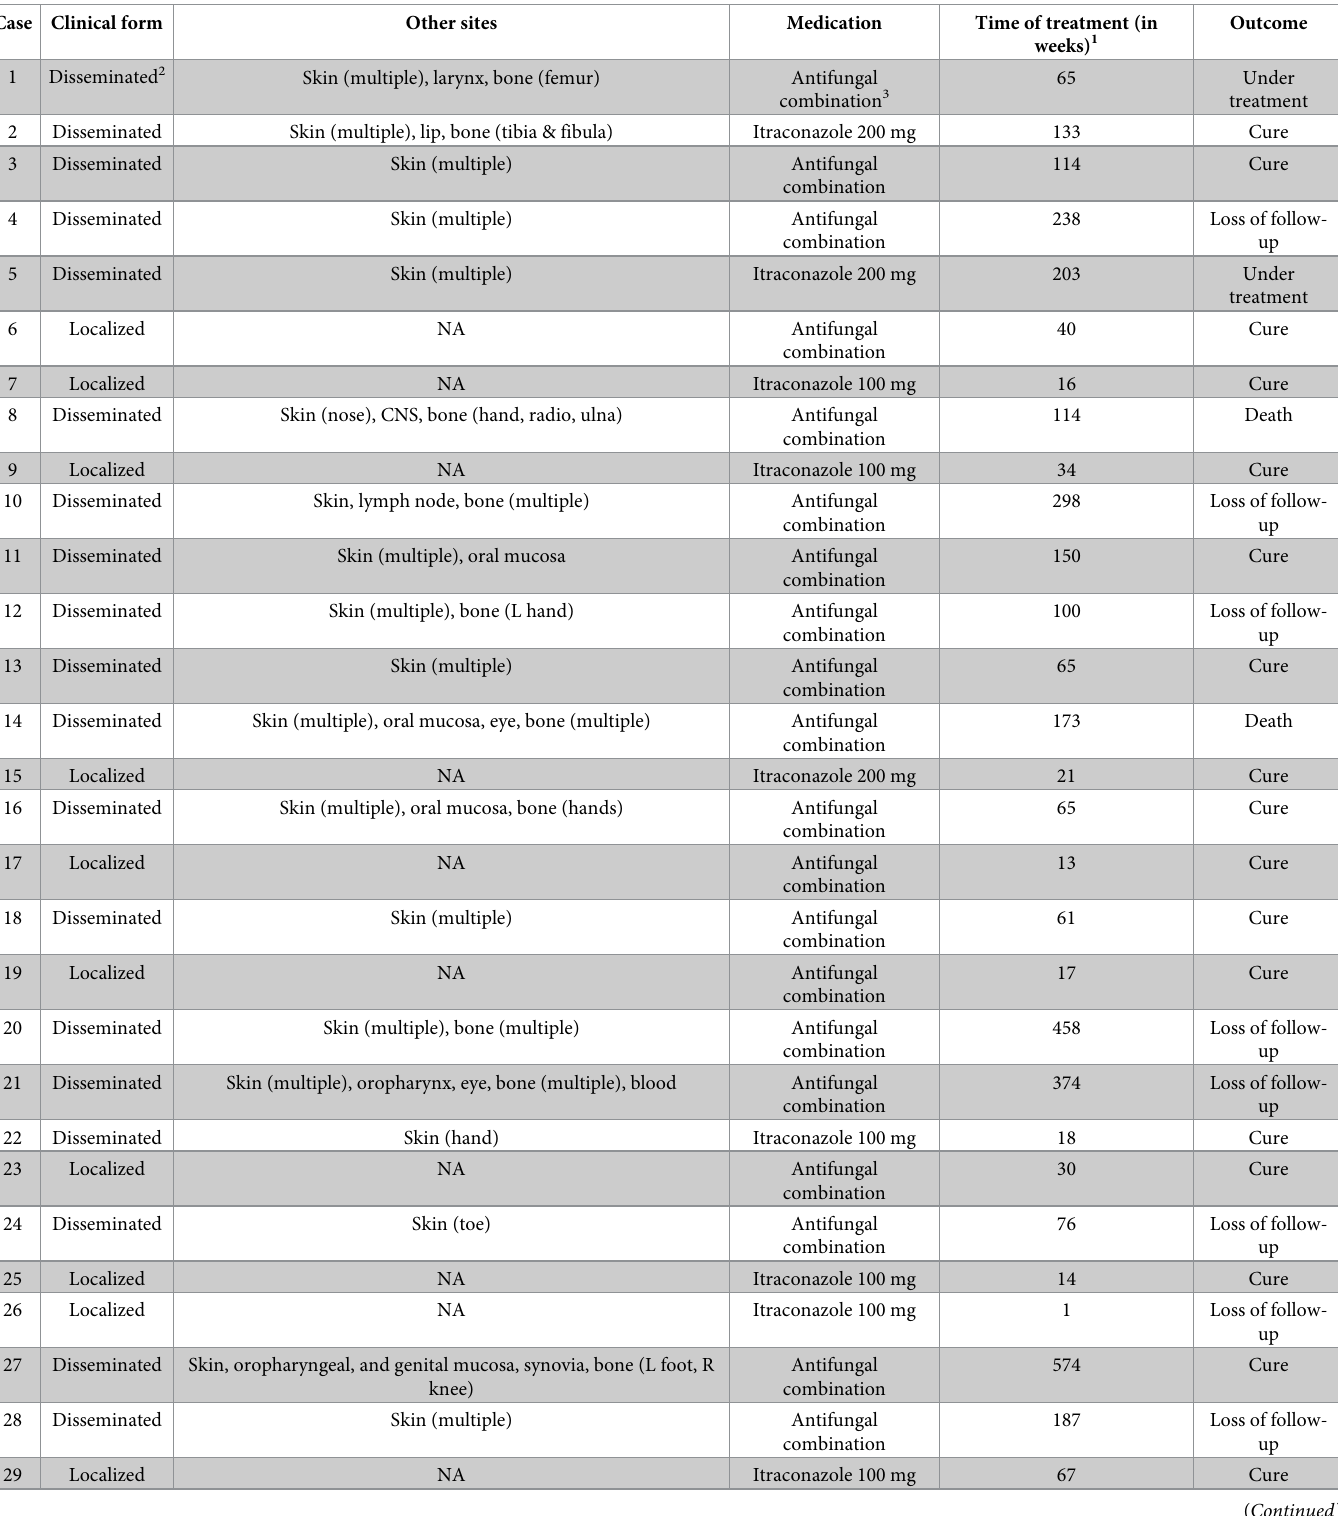
Table 2. Treatment and outcome of 37 cases of sporotrichosis in the nasal mucosa, according to clinical form, treated at the ENT outpatient clinic of the INI/FIO- CRUZ (1998–2020). Case Clinical